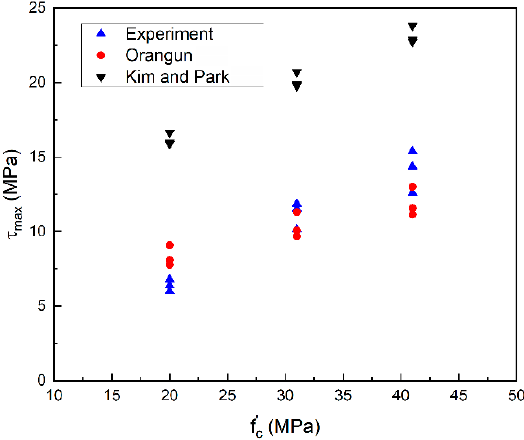
Figure 9. Comparison of experiment data and previous